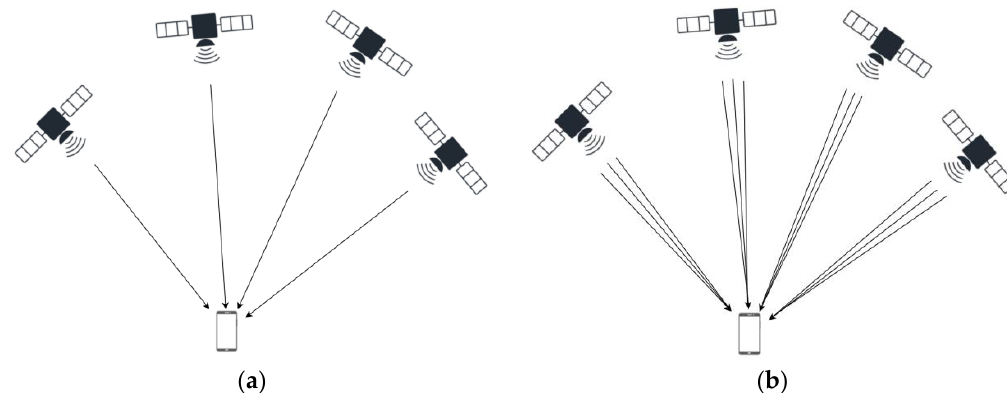
Figure 3. Comparison of downlink single-frequency and multi-frequency signals from in-orbit satellites. ( a ) Each satellite sends down one navigation signal; ( b ) each satellite sends down multiple navigation signals with multi-frequencies.